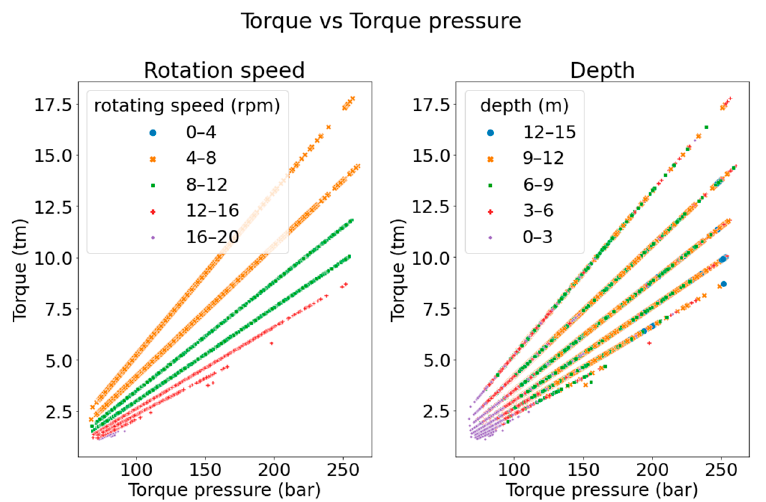
Figure 8. Rotation torque vs torque pressure measured on site 1. To the left depending on the rota– tion speed and to the right depending on the depth.